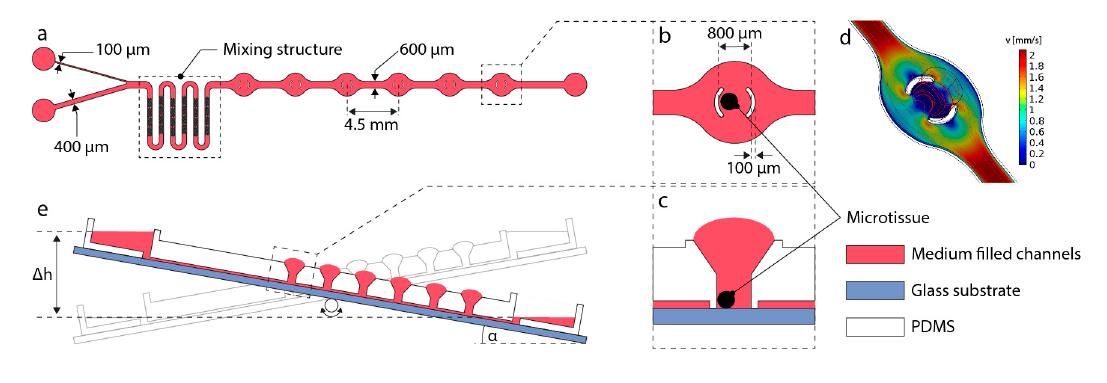
Figure 2. Design and operation of the microfluidic tilting platform ( a ) Channel layout of the device with a Y-junction to produce physiologically relevant dosing. The channel harbors a mixing structure as well as spheroid compartments. ( b ) Close-up top view and ( c ) side view of a spheroid compartment, depicting the standing drop on top of the compartment for optimal loading and the barrier structures protecting the spheroid from flow-dependent shear stress. ( d ) Assessment of the liquid velocity around the microtissue compartment to estimate shear stress (flow rate of 10 μ L min − 1 ). ( e ) Tilting of the platform by an angle α induces gravity-driven perfusion of the channels according to the height difference Δ